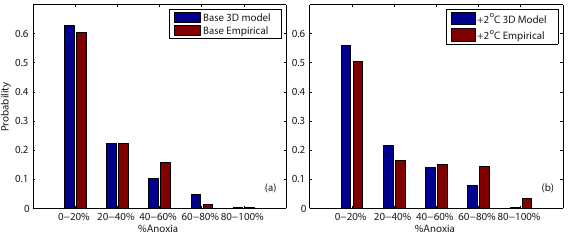
Fig. 13. Probability distribution of percent anoxia in the Yarra River estuary: blue – simulated by 3-D model; red – estimated by empir- ical model for (a) under 2009–2010 climate and (b) under + 2 ◦ C climate